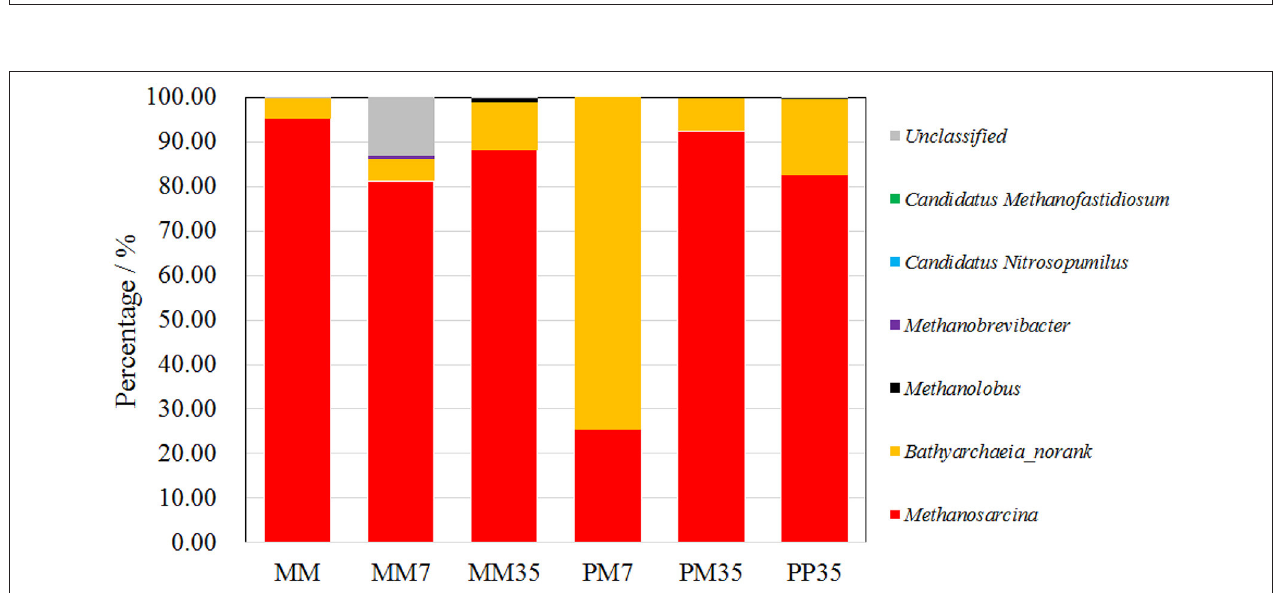
FIGURE 2 | Fungal community compositions at genus level. MM represents the cultivations with raw coal and methanogenic microflora. PP represents the cultivations with PF pretreated coal and methanogenic microflora. PM represents the cultivations with raw coal and mixed culture of PF and methanogenic microflora. The 7 and 35 are the sampling time. The genera accounted for < 1% of sequence reads were grouped into others in each sample. The scale bar represents the phylogenetic distance between samples.